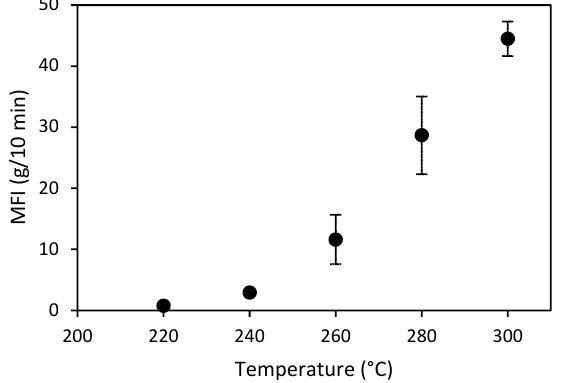
Figure 2. MFI of polycarbonate film against temperature.